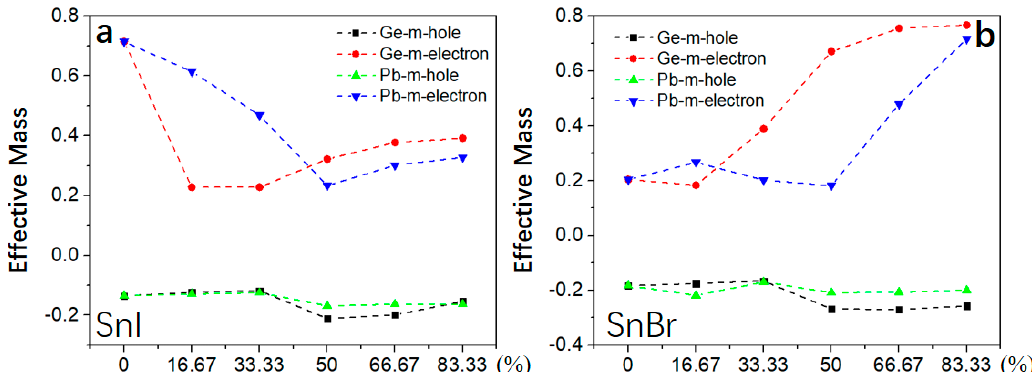
Figure 4. Carrier effective mass for 2D-HOIPs by mixing Cs/Rb atom at different concentrations (0%, 25%, 50%, 75% and 100%): ( a ) SnI-2D-HOIPs, ( b ) PbI-2D-HOIPs, ( c ) SnBr-2D-HOIPs, and ( d ) PbBr- 2D-HOIPs.